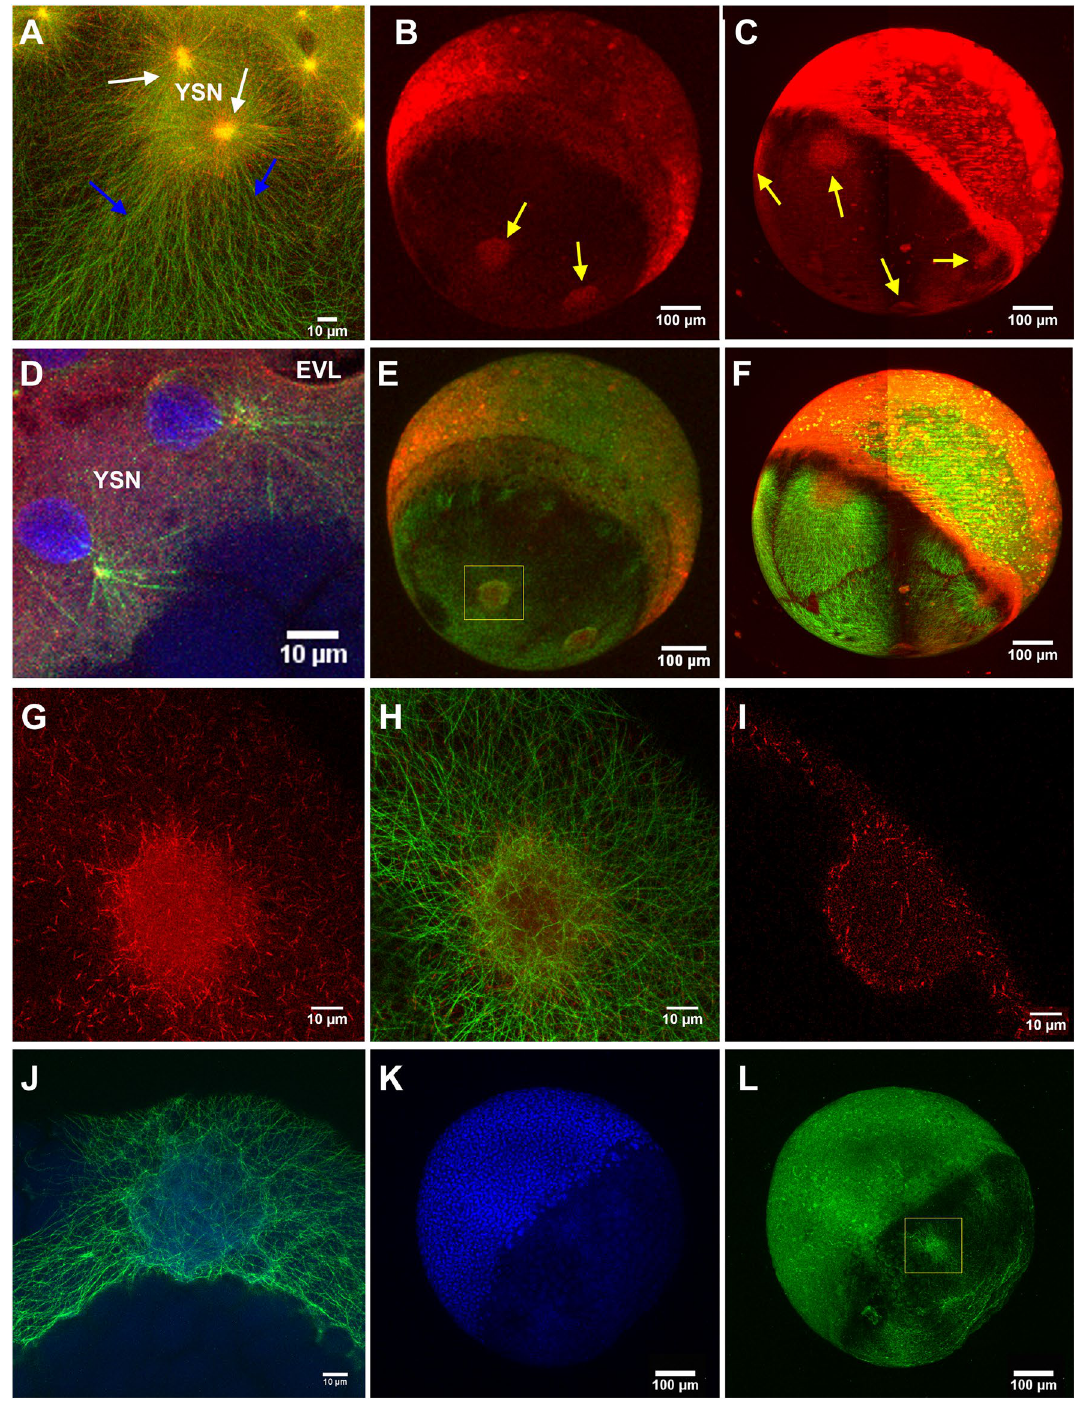
Figure 5. MT polymerization occurs at YSL and across the YCL . EB3-mCherry injected dclk2-GFP embryos allow us to simultaneously visualize MTs and MTs plus-ends. EB3-mCherry signal was found: ( A ) around e-YSN centrosomes (white arrows), as vegetalward oriented tracks in the YSL (blue arrows), and as scattered puncta all along the entire yolk cell [Merged signals, dclk2-GFP (green) and EB3-mCherry (red)]. See also Video S8. Whole imaging of the embryos using ( B ) CLSM and ( C ) LSFM also reveals the localization of EB3-mCherry signal at YCL asters (yellow arrows). ( D ) CLSM zoom in the YSL area to highlight YSL nuclei during division, in a EB3-mCherry injected dclk2- GFP transgenic embryo, fixed and stained with DAPI (blue). ( E , F ) Merged signals after adding the dclk2-GFP channel (green) to ( B ) and ( C ), respectively (red). ( G , H ) High resolution CLSM imaging of a YCL aster showing ( G ) EB3- mCherry signal and ( H ) its merge with the dclk2-GFP signal. ( I ) CLSM cross section of a YCL aster shows, through the EB3-mCherry signal, the MT polymerizing activity preferentially located at the periphery of the aster. ( J – L ) High resolution CLSM imaging of a YCL aster in a dclk2-GFP embryo, fixed and stained for DAPI (blue) at 60% epiboly. ( J ) corresponds to yellow inset in ( L ). No chromatin enriched structures are detected in YCL